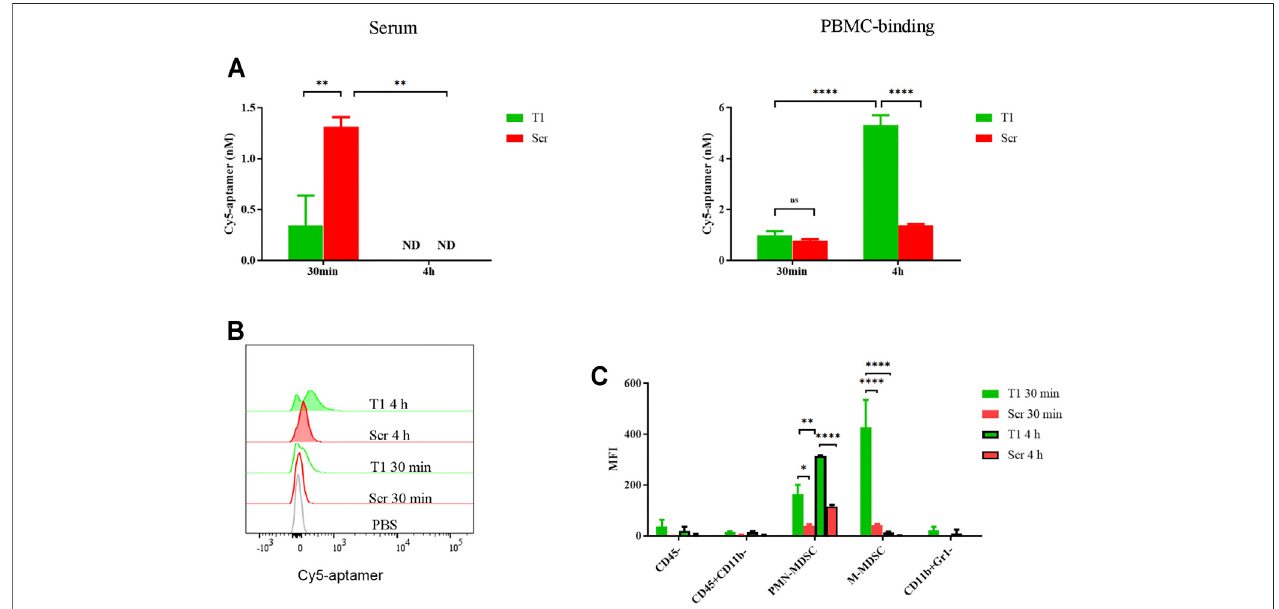
FIGURE1| Partitionofaptamerincirculation.4T1tumor-bearingmiceweretreated i.v. with0.4 nmolCy5-T1thioaptamer(T1)orCy5-scrambleaptamer(Scr),and periphery blood samples were collected 30 min and 4 h later for fl uorescent analysis. (A) Fluorescent intensity in serum and PBMCs. ND: not detectable. (B) Flow cytometry analysis of cell-associated Cy5-aptamers at the 30 min and 4 h time points. (C) Distribution of Cy5-aptamer among cell subsets in PBMC. MFI: median fl uorescence intensity.